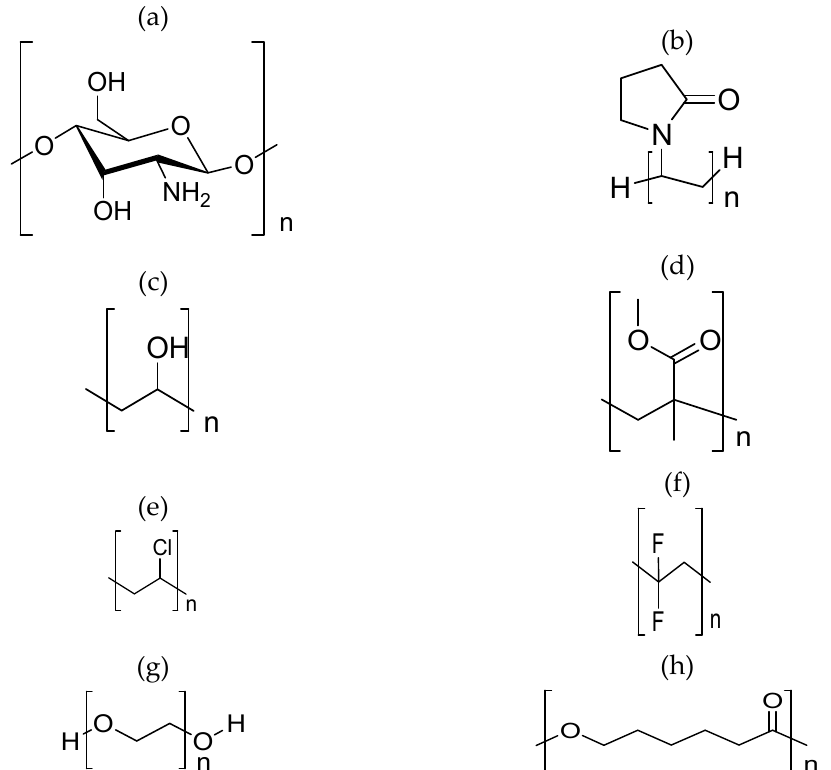
Figure 12. Chemical structure of extensively used polar polymer electrolytes: ( a ) chitosan; ( b ) polyvinylpyrrolidone (PVP); ( c ) polyvinyl alcohol (PVA); ( d ) polymethylmethacrylate (PMMA); ( e ) polyvinyl chloride (PVC); ( f ) polyvinylidene fluoride (PVDF); ( g ) polyethene oxide (PEO); ( h ) polycaprolactone (PCL).